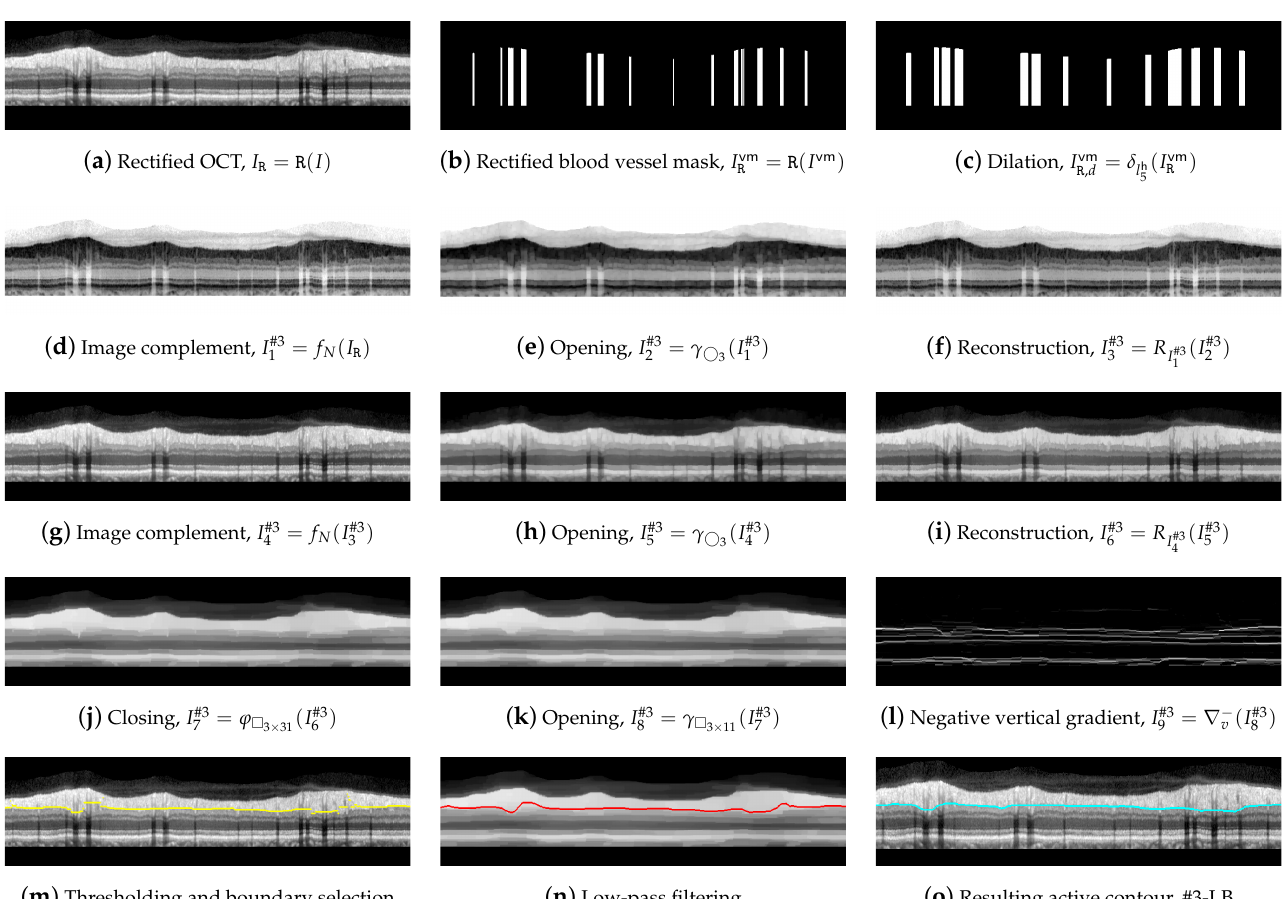
Figure 12. Delineation of the